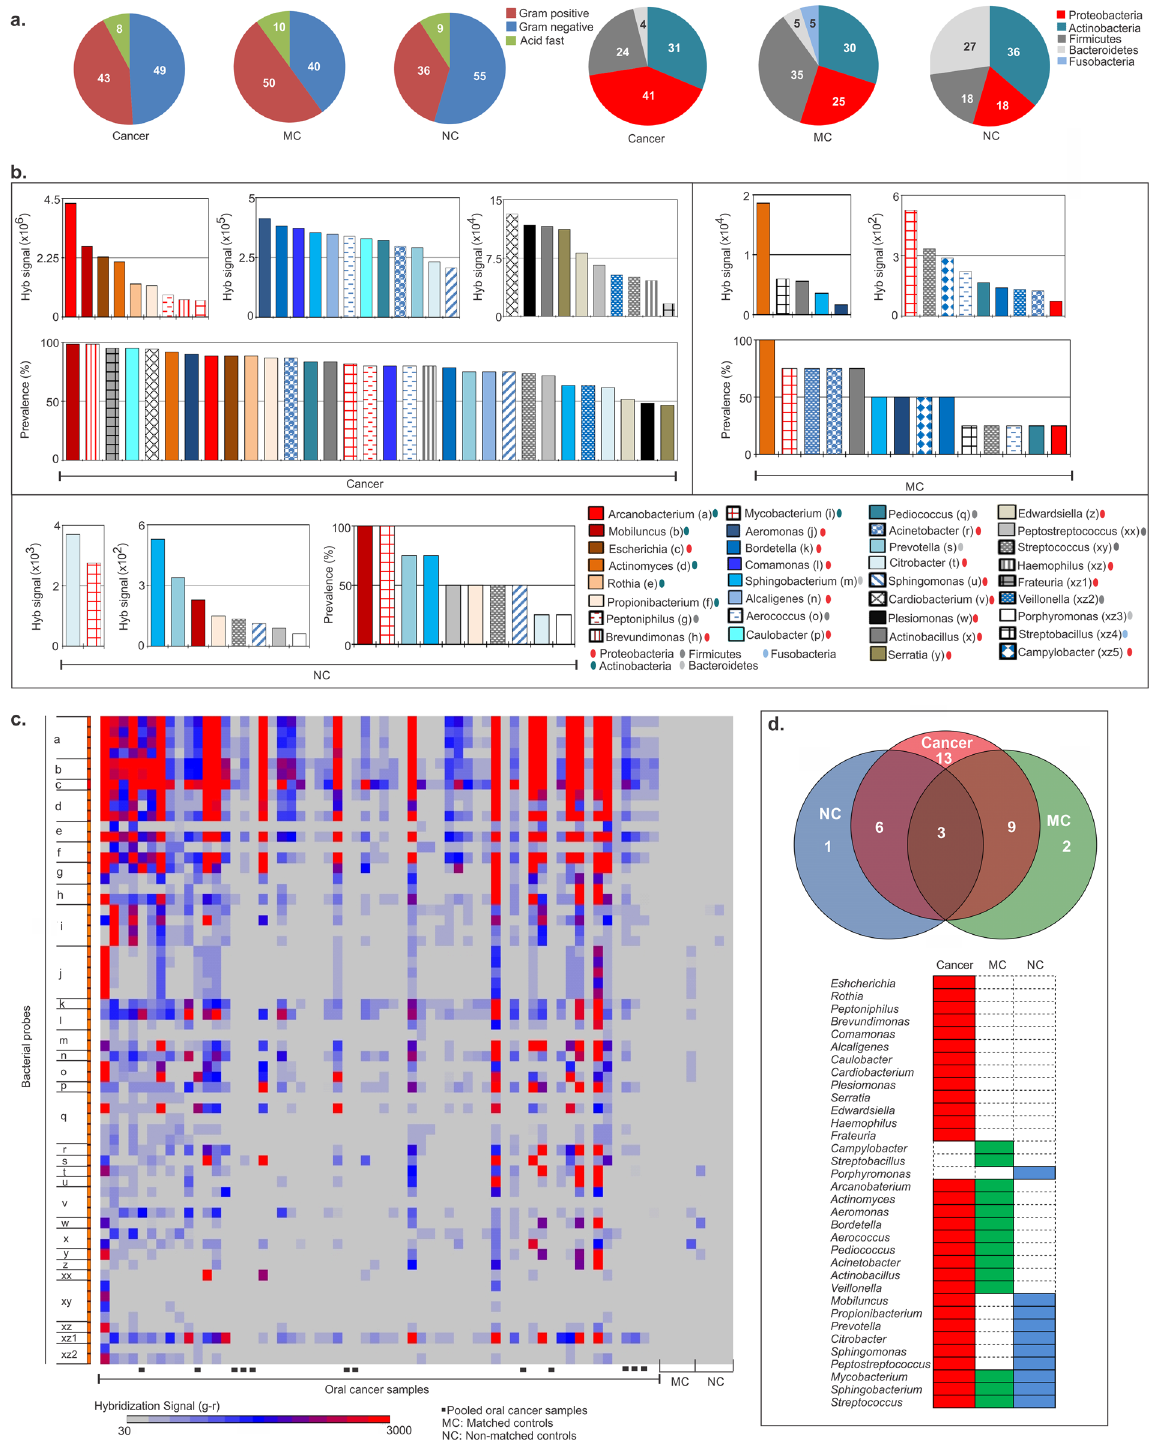
Figure 2. Bacterial signatures detected in oral cancer samples. ( a ) Pie charts showing the percentage of different groups and phyla of bacteria detected in oral cancer, matched (MC) and non-matched controls (NC). ( b ) The bacterial signatures that are detected with hybridization signal (g–r > 30) by PathoChip screen of 100 oral cancer samples and in MCs and NCs are shown and ranked according to decreasing hybridization signal (weighted score sum of all the probes per accession) and prevalence. ( c ) Figure c shows the heat map of the hybridization signal for the bacterial probes of bacterial genera a-xyz, labeled in figure b , detected by PathoChip screen with the cancer, matched (MC) and non-matched control (NC) samples. Samples were screened individually and in pools (marked ▪ ). ( d ) Figure d shows the association of molecular signatures of different bacterial genera with oral cancer and/or controls, represented as a venn diagram, and as colored